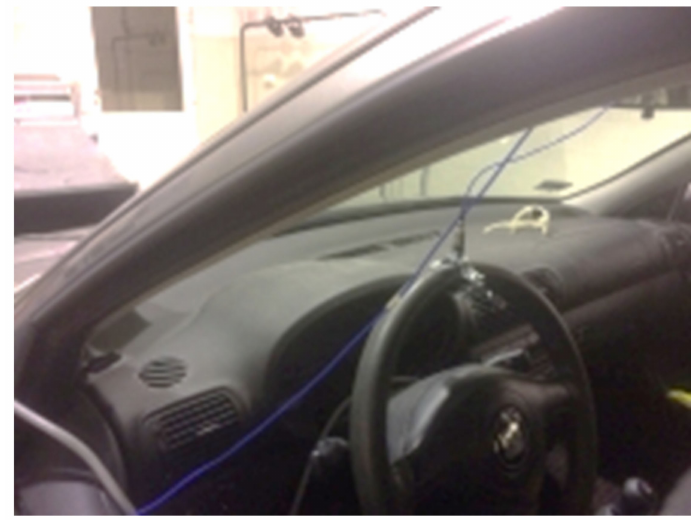
Figure 2. The sensor mounted on the steering wheel.